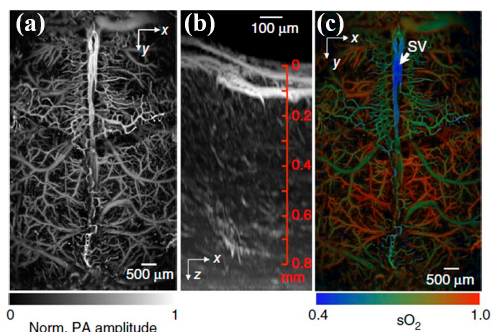
Figure 20. Photoacoustic in vivo imaging of the mouse brain. ( a ) Representative x-y projected brain vasculature image through an intact skull ( n = 6). ( b ) Representative enhanced x-z projected brain vasculature image acquired over a 0.6 × 0.6 mm 2 region with depth scanning, where the signal amplitude was normalized depthwise ( n = 6). ( c ) PAM of oxygen saturation of hemoglobin (sO 2 ) in the same mouse brain as in (a), acquired by using the single-wavelength pulse-width-based method (PW-sO 2 ) with two lasers. SV, skull vessel (Reproduced with permission from Nature Publisher Group [112]).